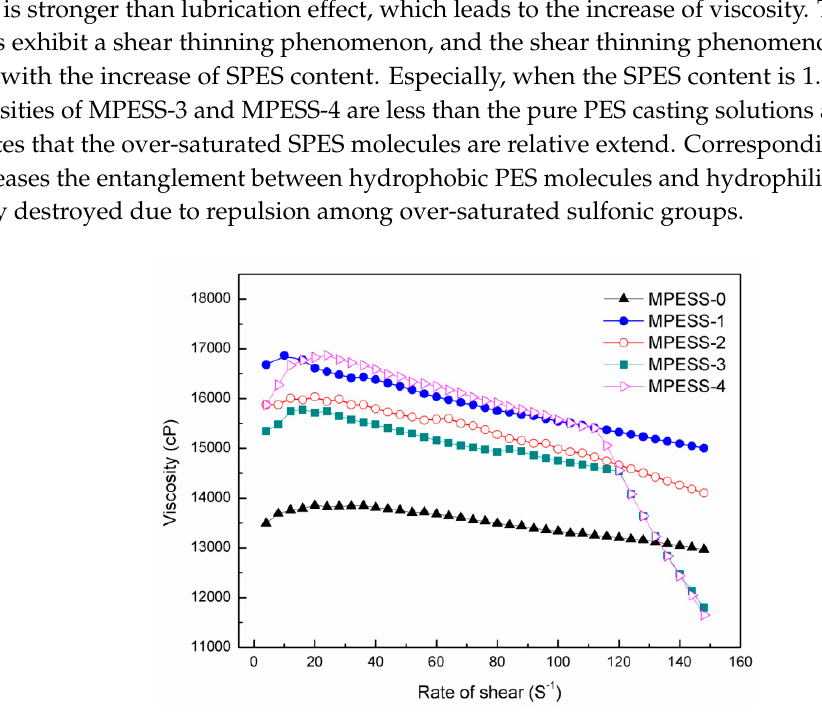
Figure 2. Shear viscosities of the PES/SPES/DMAc/PEG200 casting solutions.